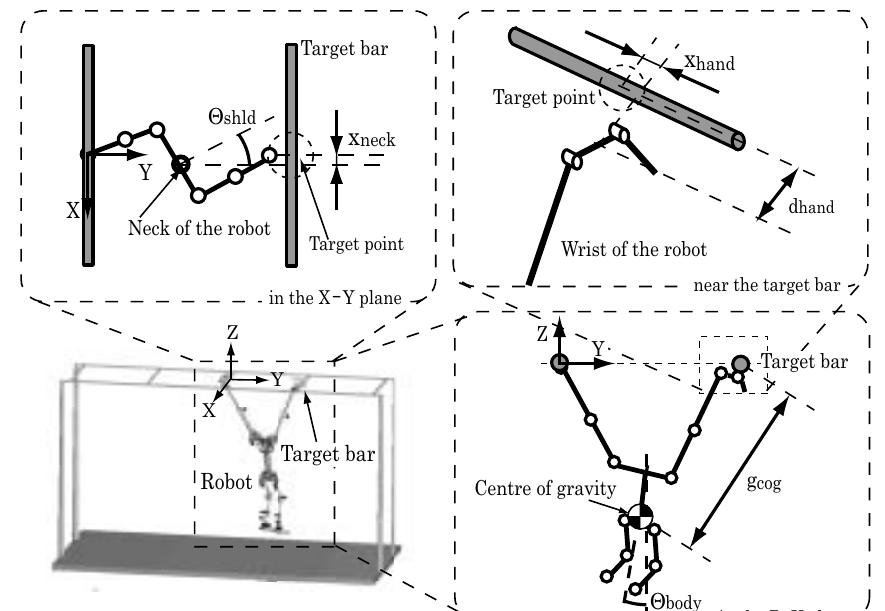
Figure 14 Elements of the performance vector p